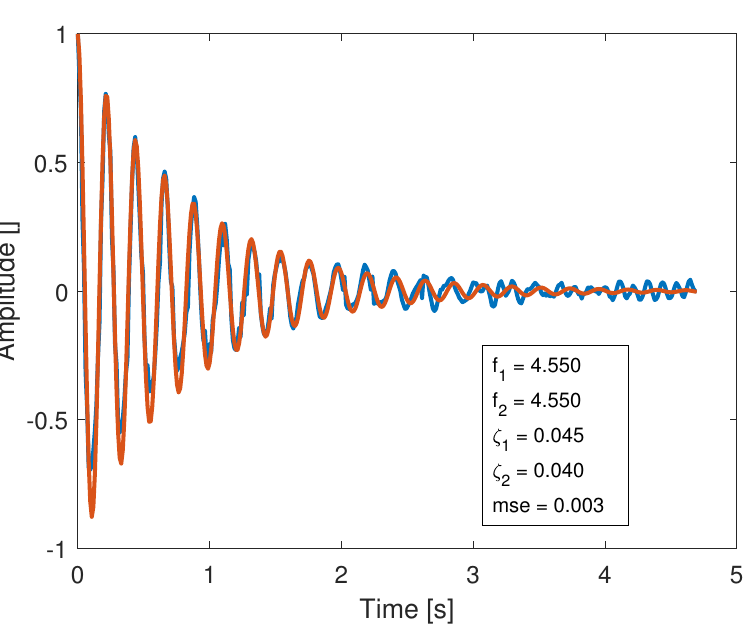
Figure 16. Original signal (blue) and signal reconstruction processed by the Laplace Wavelet tech- nique (red). MSE order 1 (lower order means better